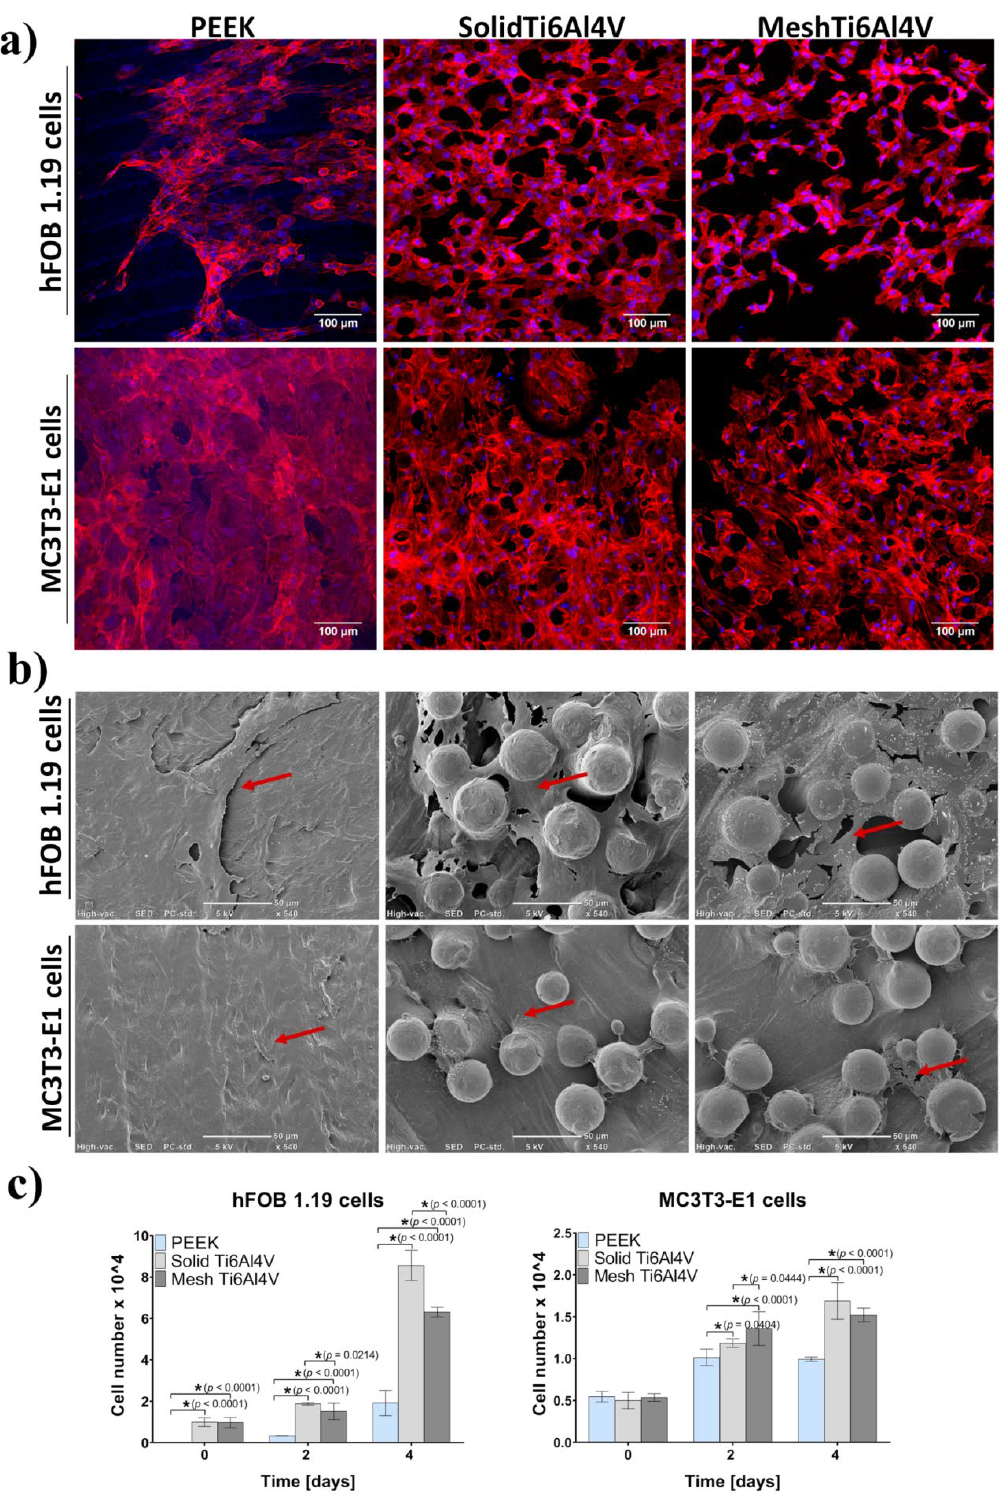
Figure 7. Cell growth and proliferation on the tested materials: ( a ) CLSM images presenting osteoblasts’ growth after four-day culture (red fluorescence—actin cytoskeleton, blue fluorescence—nuclei; magnification 200×, scale bar = 100 μm); ( b ) SEM micrographs presenting osteoblasts growth after four-day culture (red arrows indicate sheet of osteoblasts on the samples; magnification 540×, scale bar = 50 μm), ( c ) quantitative evaluation of cell proliferation (* indicates statistically significant results according to One-way ANOVA followed by Tukey’s multiple comparison test).